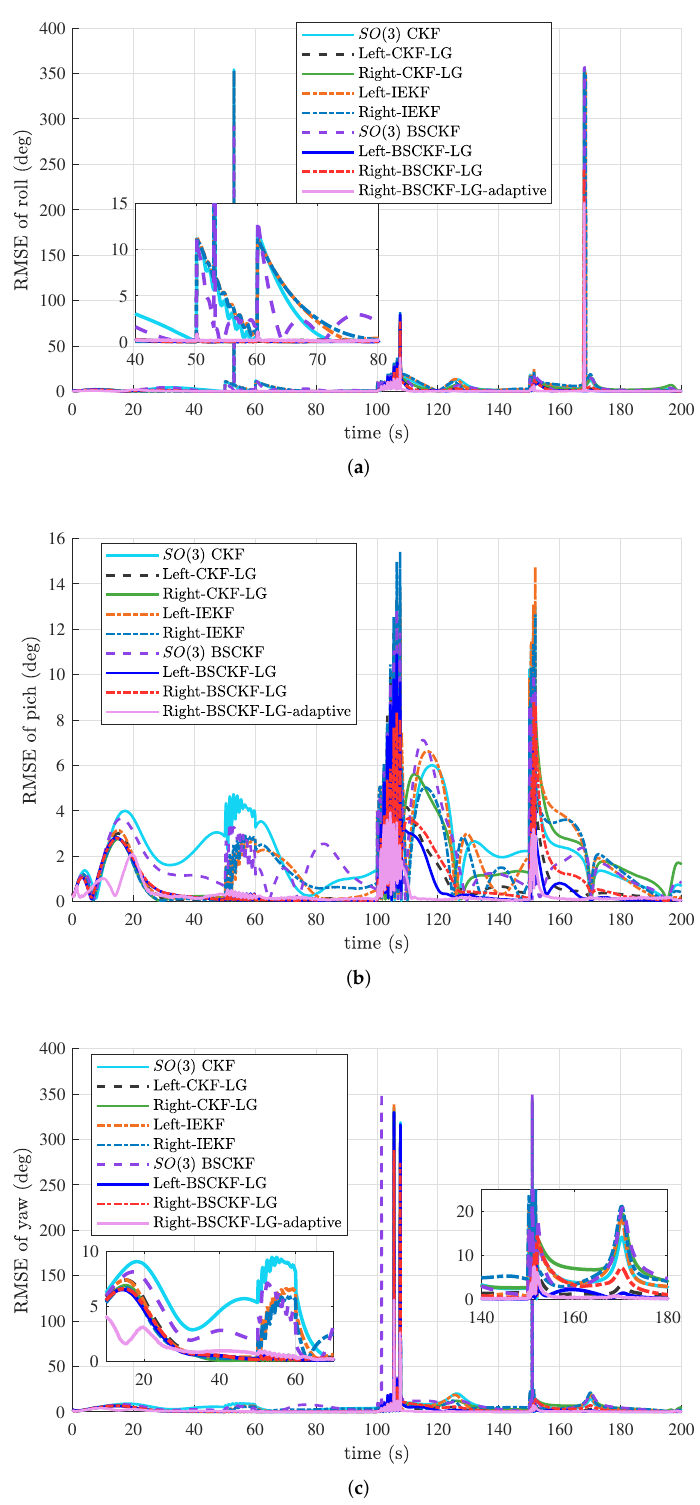
Figure 6. RMSEs of Euler angles in Case 3. ( a ) RMSEs of roll angle; ( b ) RMSEs of pitch angle; ( c ) RMSEs of yaw